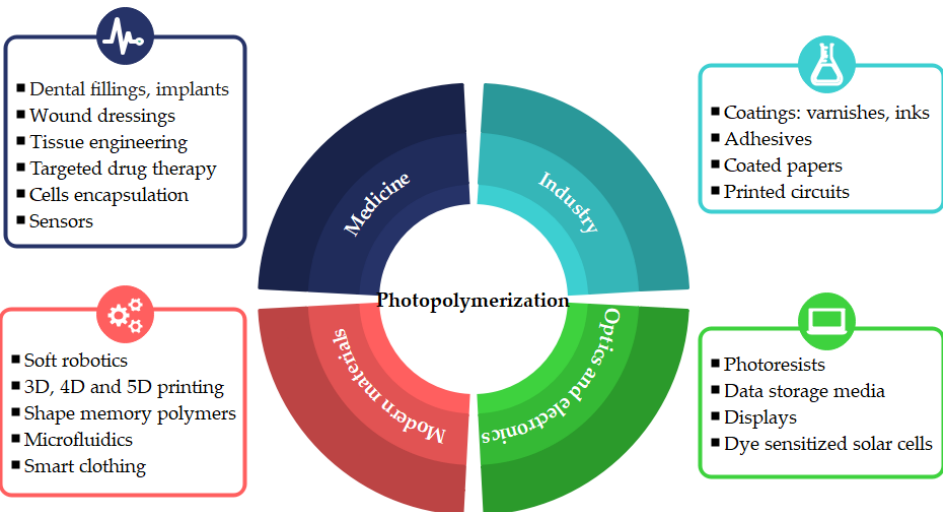
Figure 1. Areas with applications for photopolymerization technology.